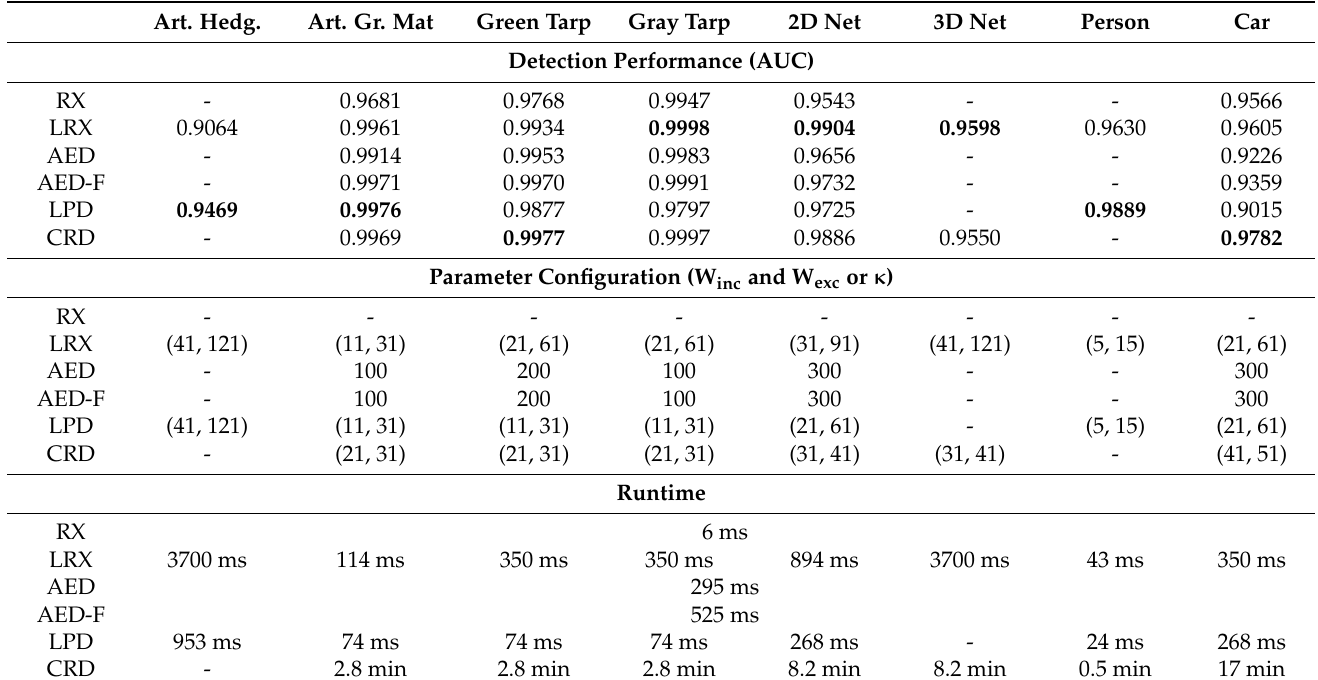
Table 3. Class-wise detection performances, parameter configurations and runtimes of each method applied on the raw version of MUCAD. Detection results with an AUC less than 0.9 were replaced with a “-” for better